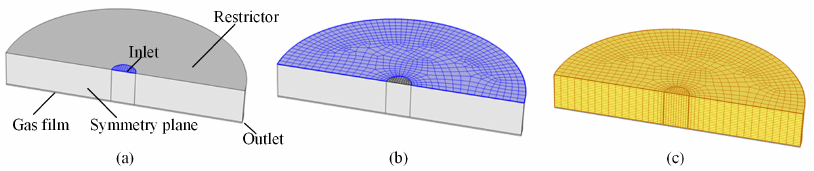
Figure 2. FEM FSI meshing: ( a ) refined meshing at inlet; ( b ) meshing at the upper surface; and ( c ) sweep meshing from top to bottom.